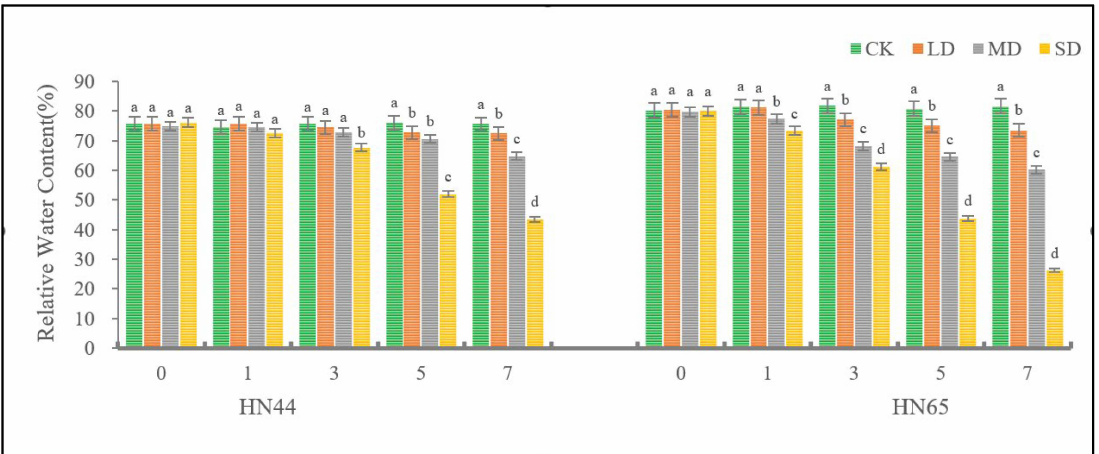
Figure 1. Changes in activities of Relative Water Content of HN44 and HN65 over time under different drought degrees. CK: Control; LD: Light Drought; MD: Moderate Drought; SD: Severe Drought. Different letters in treatments indicate significant differences according to Duncan’s single factor variance test at the 5% level, and data are presented as mean ± SE (standard error) ( n = 2).